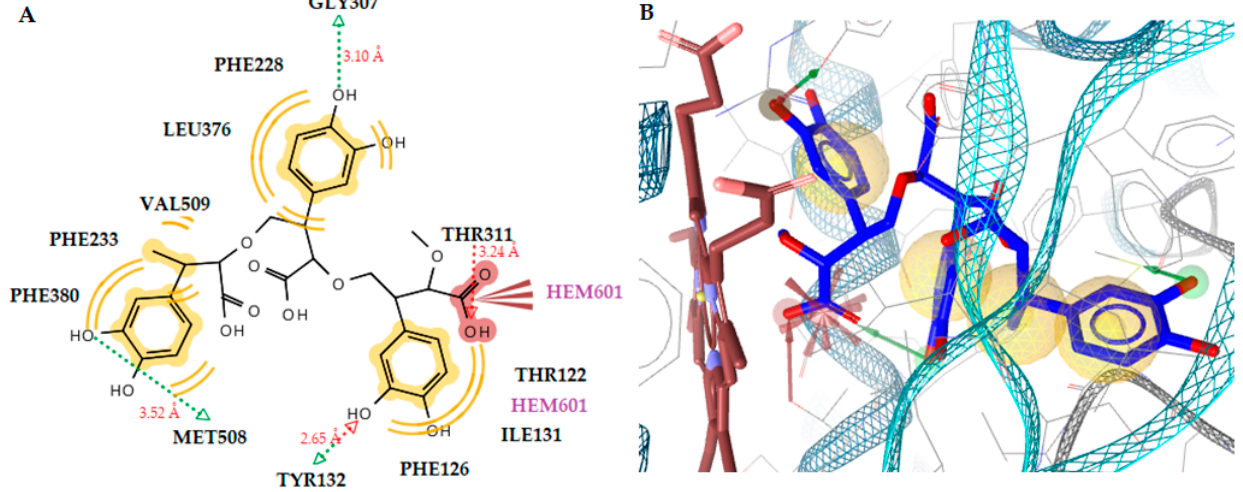
Figure 6. ( A ) A 2D diagram of trimer molecule 1 in CYP51 ca . ( B ) Docked pose of trimer molecule 1 in CYP51 ca . Red and green dotted lines show the hydrogen bonds. Yellow spheres represent hydrophobic interactions, and blue arrows represent aromatic interactions.